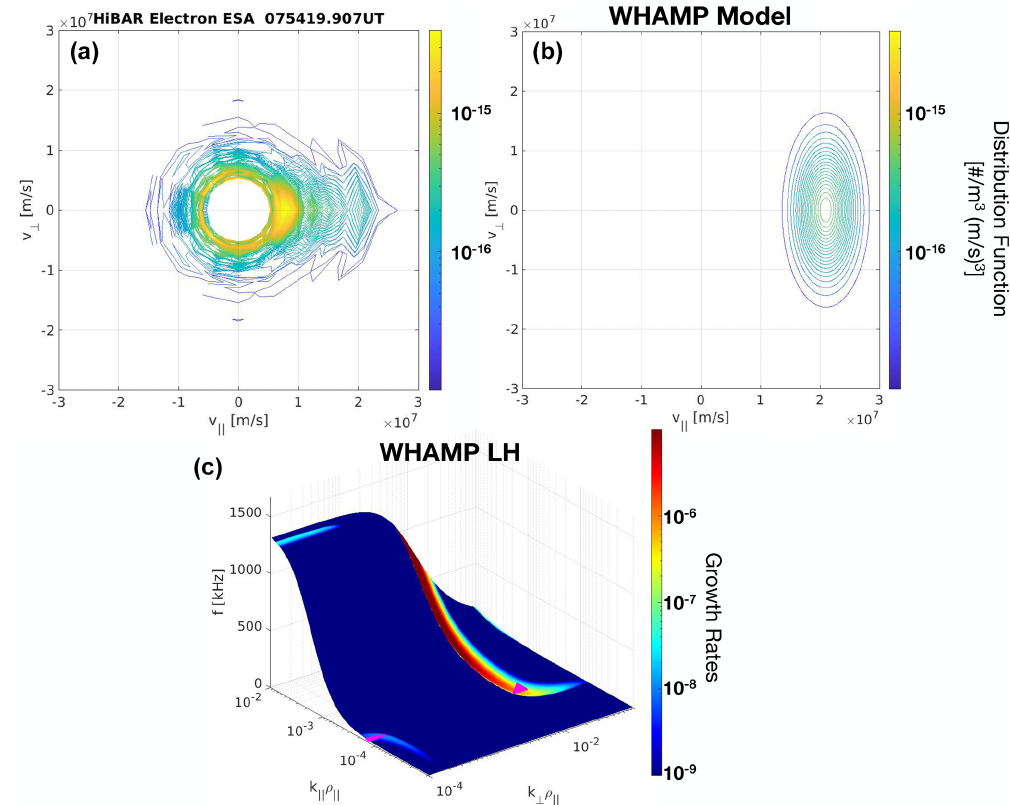
Figure 8. Measured electron distribution function from HIBAR’s electron ESA data at 07:54:19.907 (a) and model of the high-energy beam seen in the measured distribution using a drifting Maxwellian (b) . Panel (c) shows the growth rates on the whistler/LH-mode surface produced by the model WHAMP distribution, along with the frequency- and wavenumber-matching conditions for the event labeled 260s in pink. The Langmuir/Z-mode surface showed no growth on the surface from this